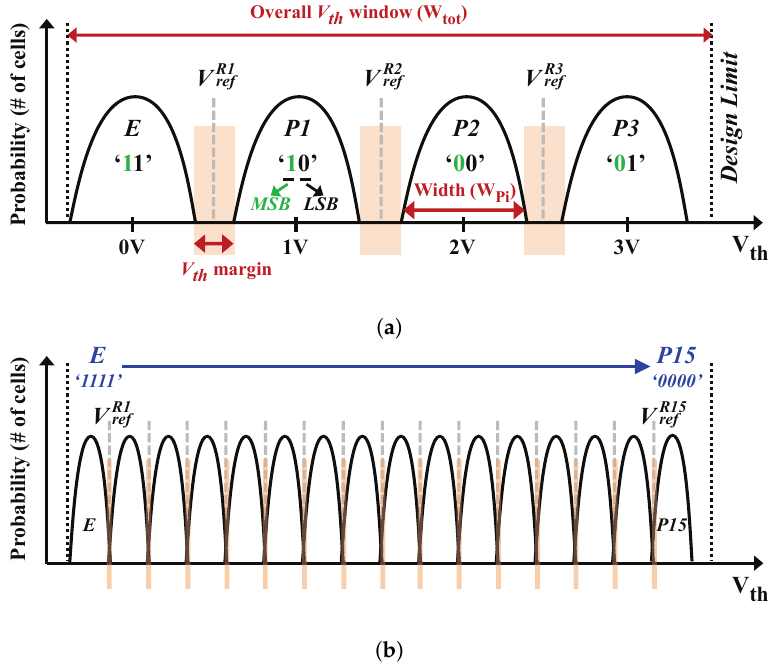
Figure 2. V th distributions of 2 m -state NAND flash memory. ( a ) m = 2: 2 bit multi-level cell flash (MLC flash memory). ( b ) m = 4: 4 bit multi-level cell flash (QLC flash